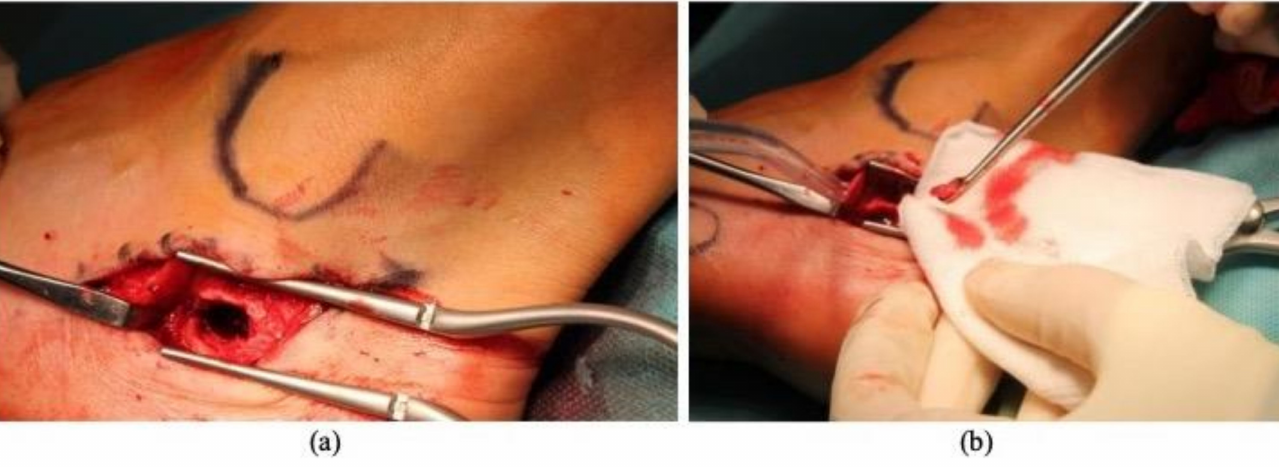
Figure 3. Intraoperatory images during a curettage ( b ) of an intraosseous lipoma of the calcaneum through a lateral approach. The peroneus tendons were reclined and a bone window, immediately distal to the lateral processus of the calcaneum ( a ), was performed in order to get access to the